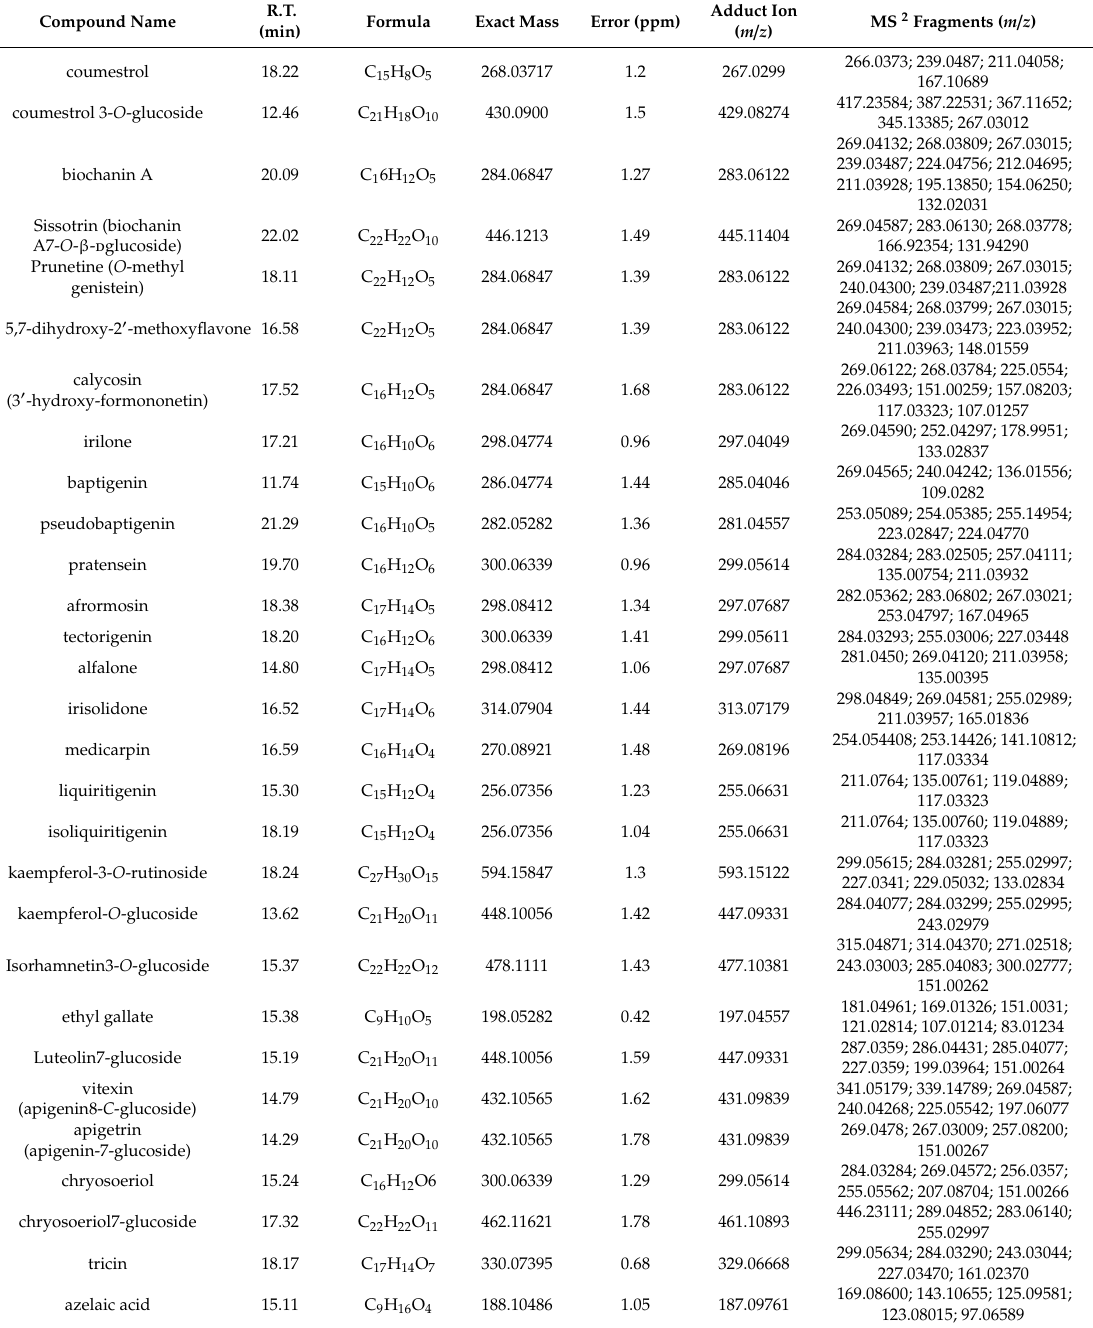
Table 2. The 29 compounds identified from alfalfa and red clover sprouts by UHPLC-Q-Exactive for which the structures were presumed based on high-accuracy analysis of deprotonated precursors and fragment ions of specific